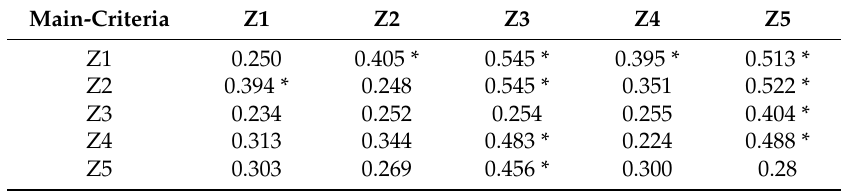
main criteria. Double arrows represent significant mutual effects between two criteria and dotted lines represent obvious one-way causal effects. Table 13. The crisp total relation matrix for the main criterion. Table 13. The crisp total relation matrix for the main criterion.